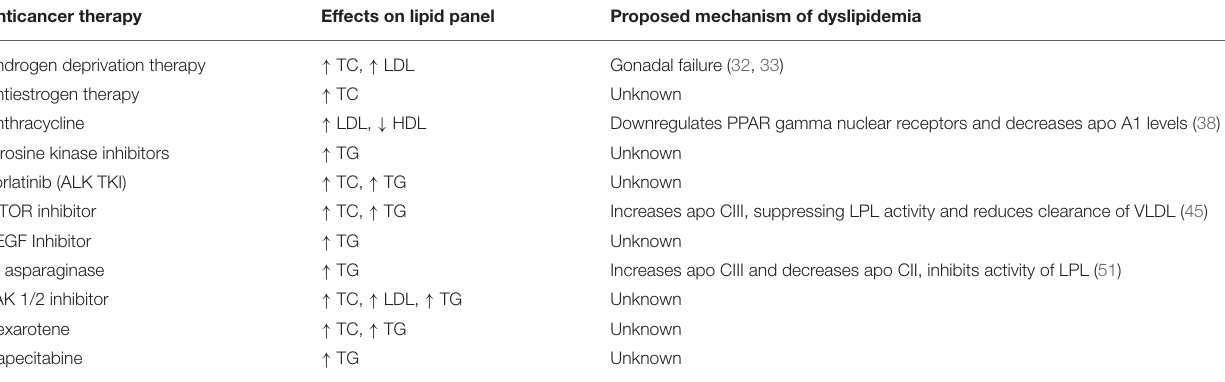
TABLE 1 | List of anticancer therapies associated with dyslipidemia, their adverse effects on lipid profile, and the proposed mechanisms of dyslipidemia. Anticancer therapy